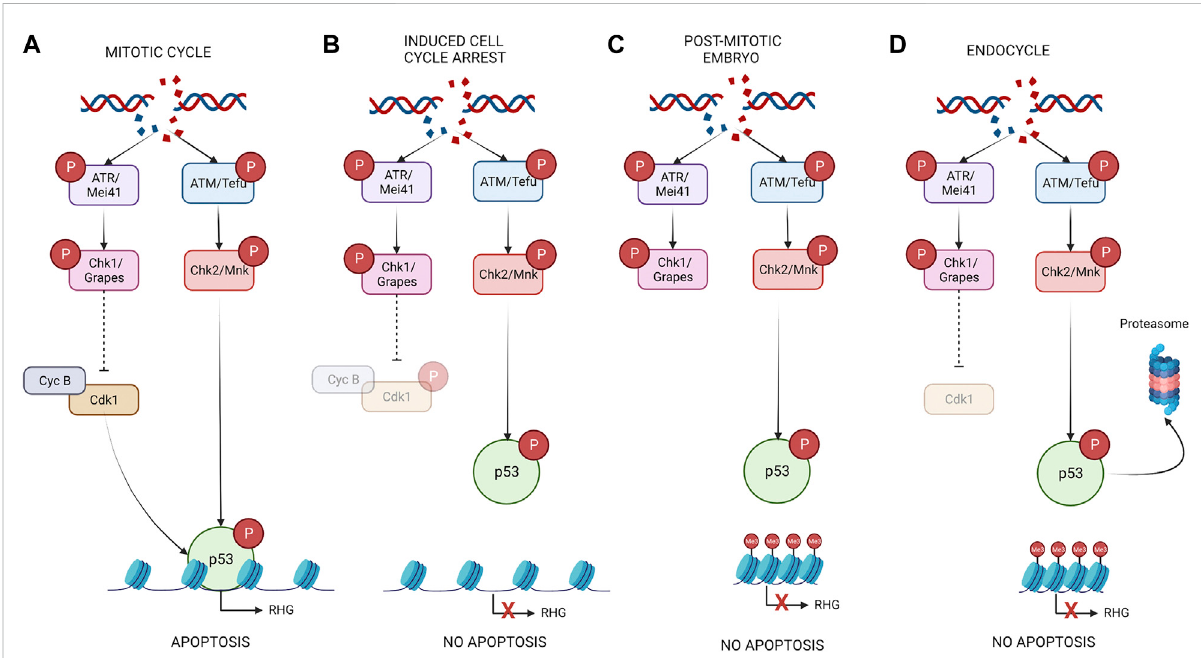
FIGURE 2 DNA damage can lead to different outcomes depending on thecell cycle stage ofthe cell. (A) In cycling cells, IR activates p53 through the DDR pathway. The presence of an active CycB/Cdk1complex facilitates the binding of p53 to the proapoptotic genes and therefore the induction of apoptosis. (B) Ininducedcellcyclearrestedcellsp53isinitiallyactivatedbyDDRpathway,howeversincethesecellsdonothaveactiveCdk1,p53fails toinducetheexpression of rpr and hid. (C) Inembryonicpost-mitoticcells, theepigeneticsilencingoftheIRERinterfereswiththeabilityofp53 toregulatetheexpressionoftheproapoptoticgenes. (D) InendocyclecellseventhoughtheDDRpathwayisactiveinresponsetoIR,apoptosisisnot induced. This is due to at least two mechanisms of control. On one hand, an epigenetic silencing at the regulatory region of the proapoptotic genes blocks the ability of p53 to induce their expression. Secondly, the levels of p53 in these cells are signi fi catively lower that in mitotic tissues through p53 targeted degradation by the proteasome. Created with